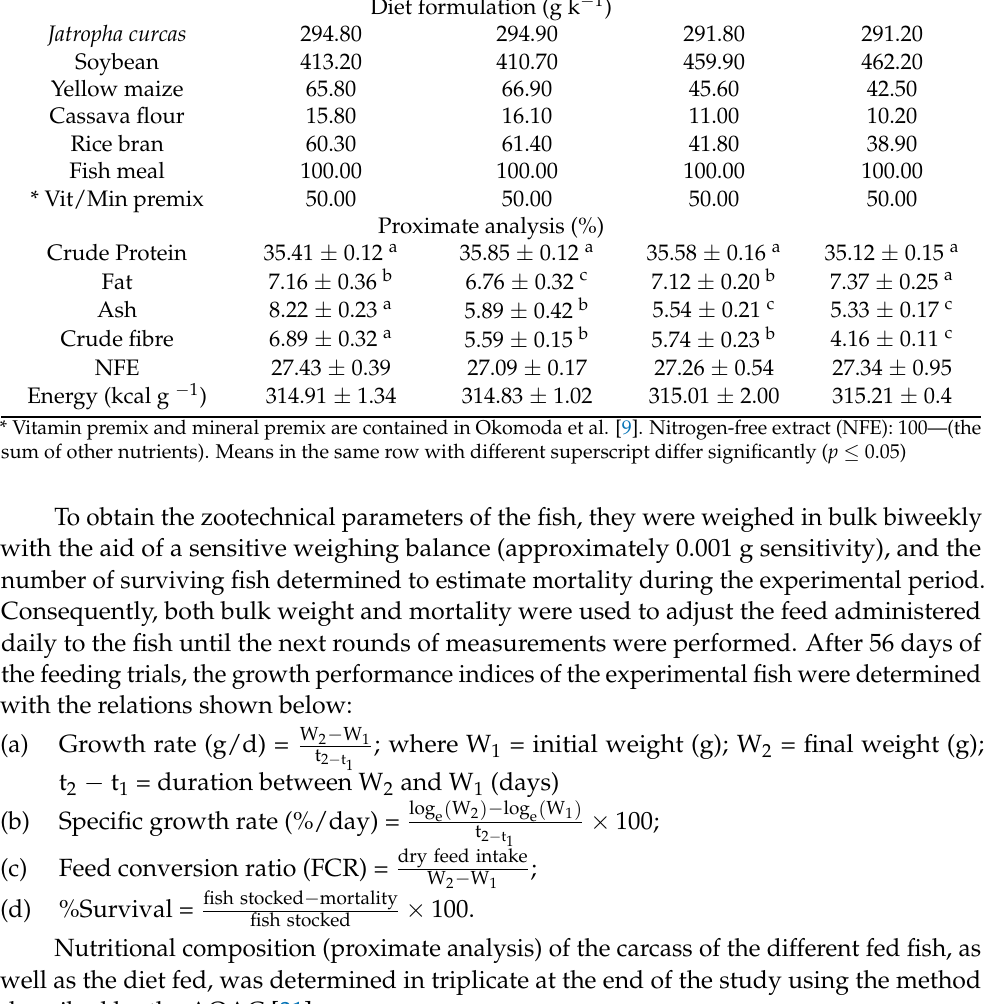
Table 2. Gross and proximate composition (%) of the diets included with soaked Jatropha curcas kernel at different durations. Numbers are means ± standard errors (gross composition = feed amount per kg of diet formulated). Soaking Parameter